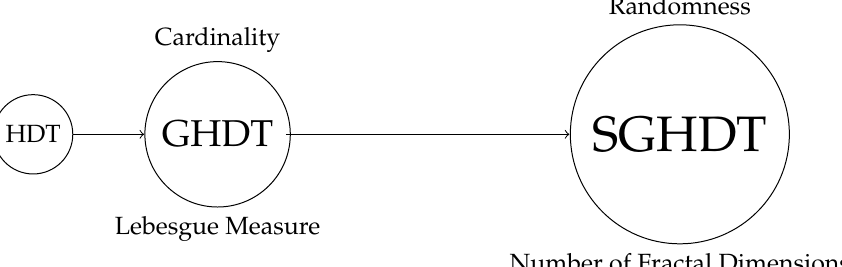
Figure 1. The generalization process of the Hausdorff Dimension Theorem(HDT) in terms of cardi- nality, Lebesgue measure, randomness and number of fractal